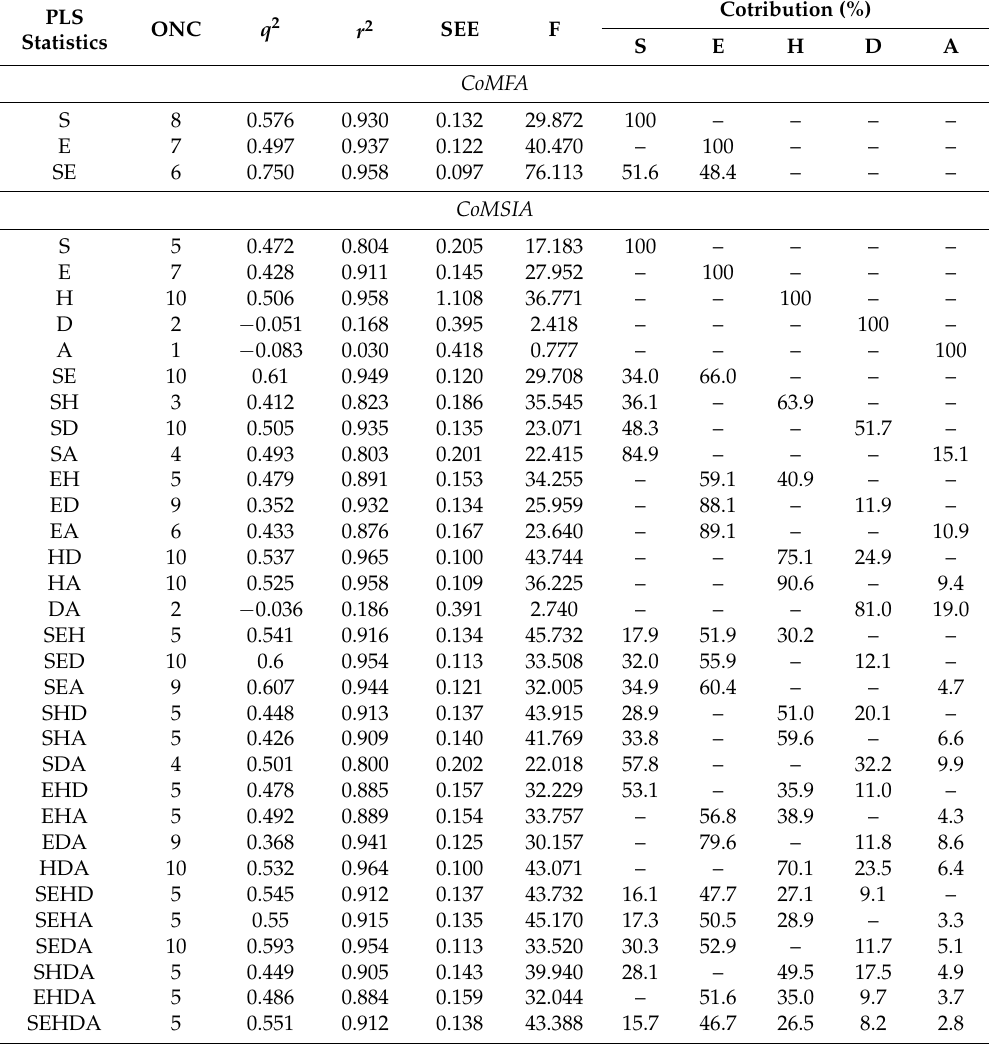
Table 1. Statistical parameters of the CoMFA and CoMSIA models.